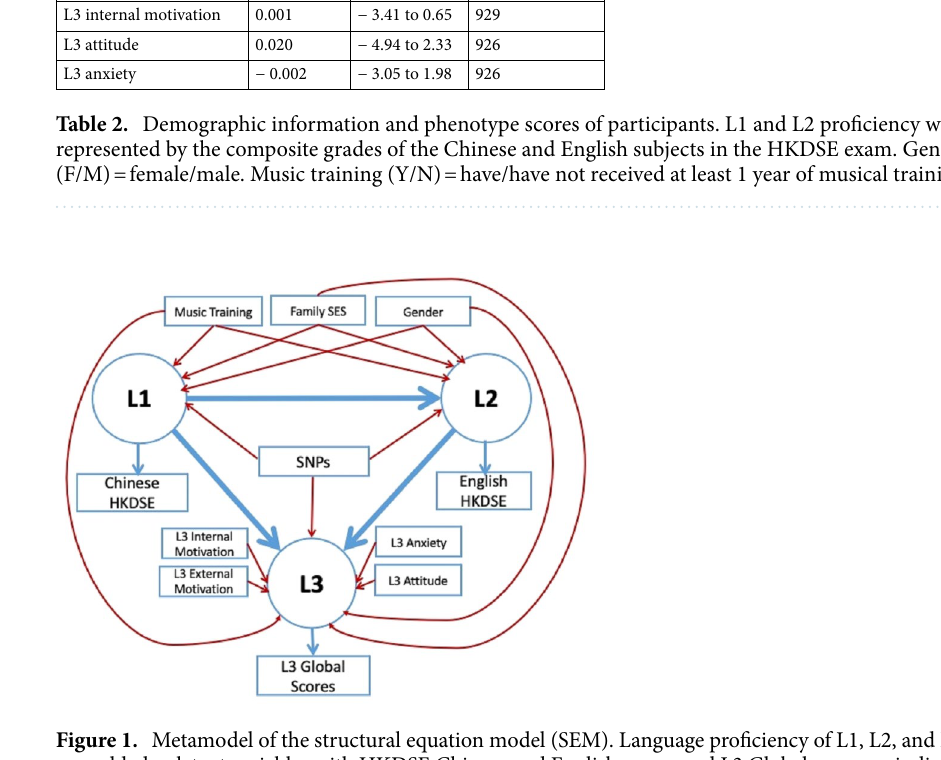
Figure 1. Metamodel of the structural equation model (SEM). Language proficiency of L1, L2, and L3 was added as latent variables with HKDSE Chinese and English scores and L3 Global scores as indicators, respectively. The significant SNPs in the final models of the stepwise regression and all non-genetic factors were entered into the